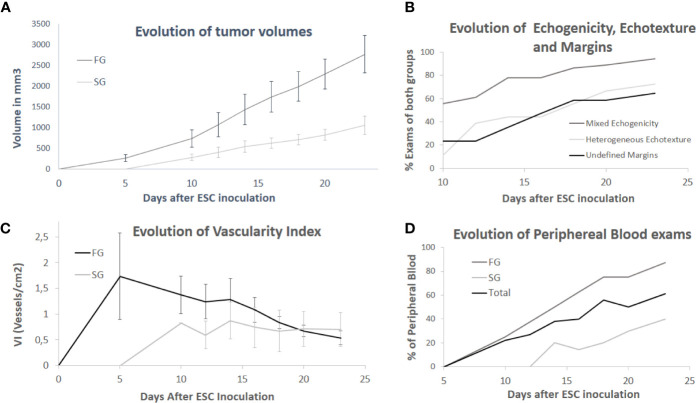
Graphics showing the evolution during 23 days of some variables of two groups of Swiss Albino mice inoculated with Ehrlich Solid Carcinoma with different tumor growth pattern. (A) The mean of volumes with standard deviation. (B) Percent of exams showing mixed echogenicity, homogeneous echotexture and undefined margins. (C) Vascularity Index. (D) Percent of exams with peripheral blood flow.